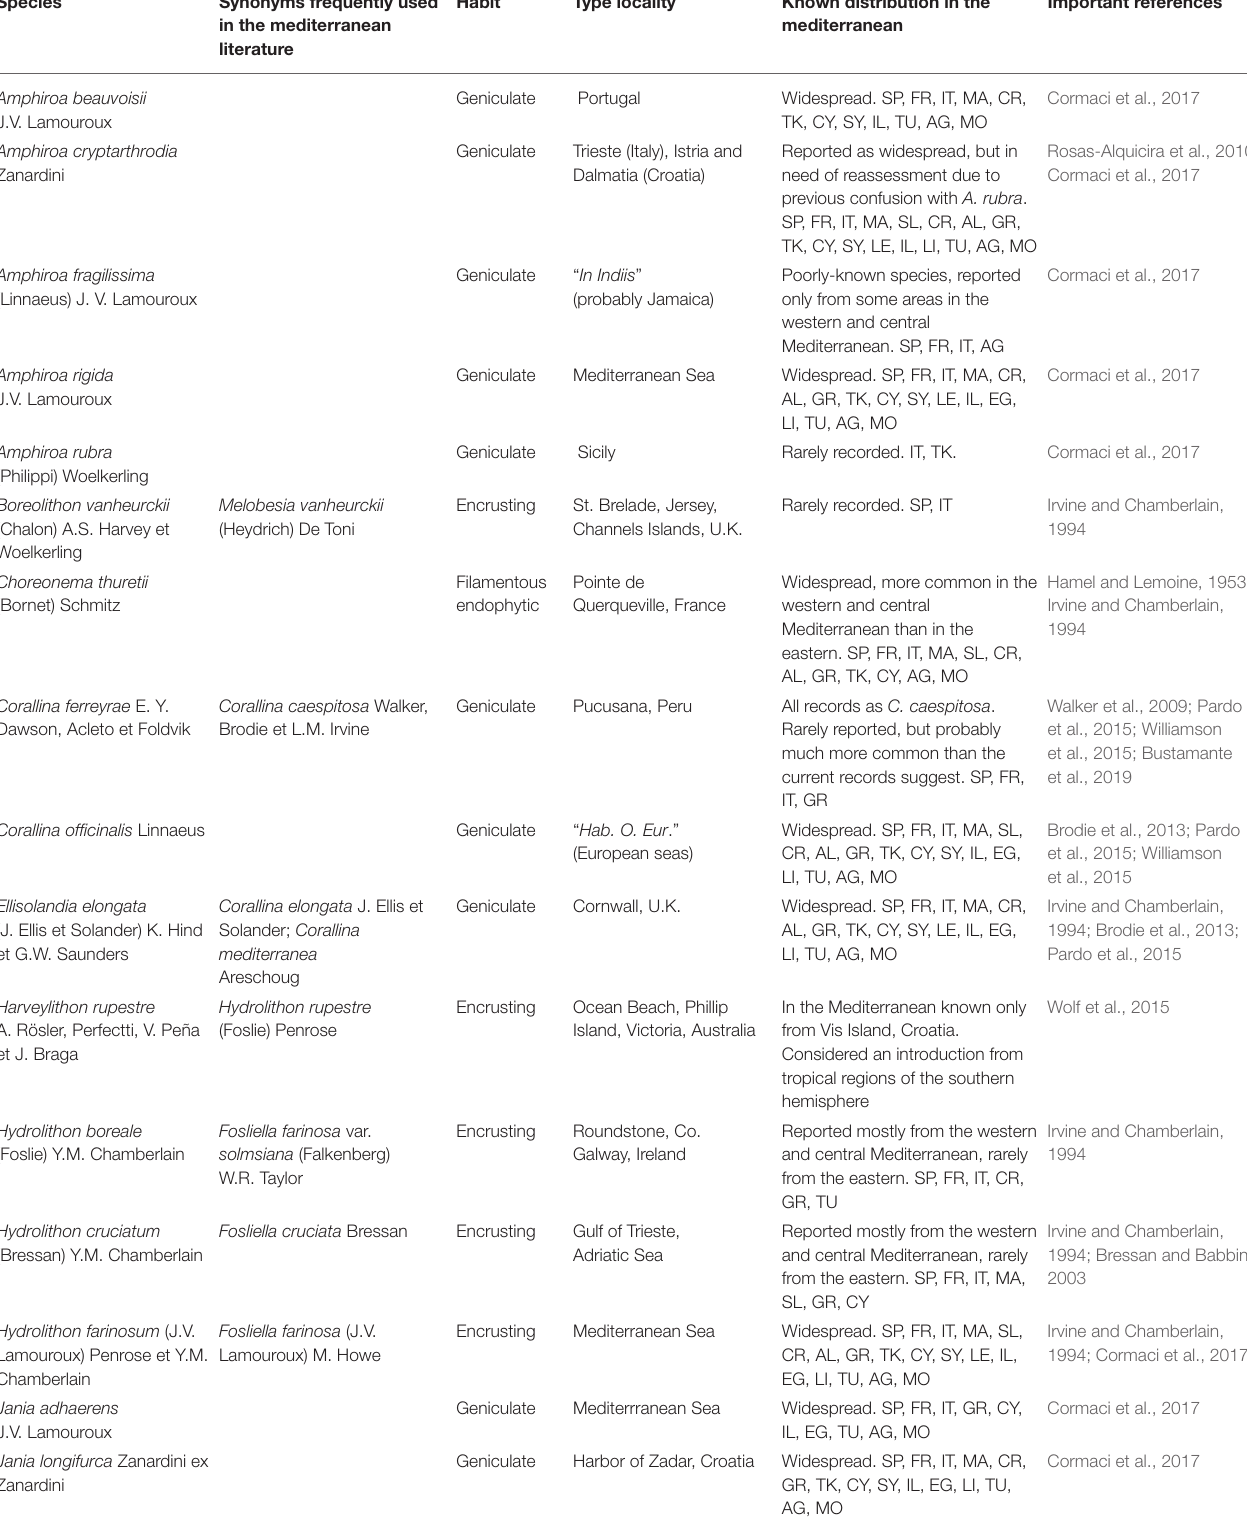
TABLE 1 | Species of coralline algae reported for the Mediterranean Sea and currently regarded as taxonomically